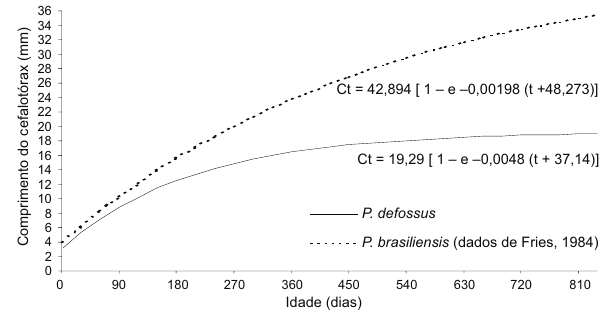
Figura 4. Comparação entre as curvas de crescimento em compri- mento da carapaça de juvenis de P. defossus e P. brasiliensis , segun- do dados de F RIES (1984), cultivados em